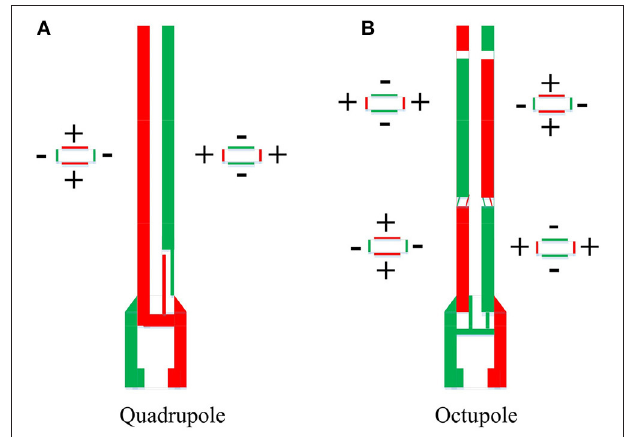
FIGURE 5 | Schematic of two different electrode pattern configuration. (A) Quadrupole pattern. (B) Octupole pattern. Reprinted with permission from [89] © The Optical Society.